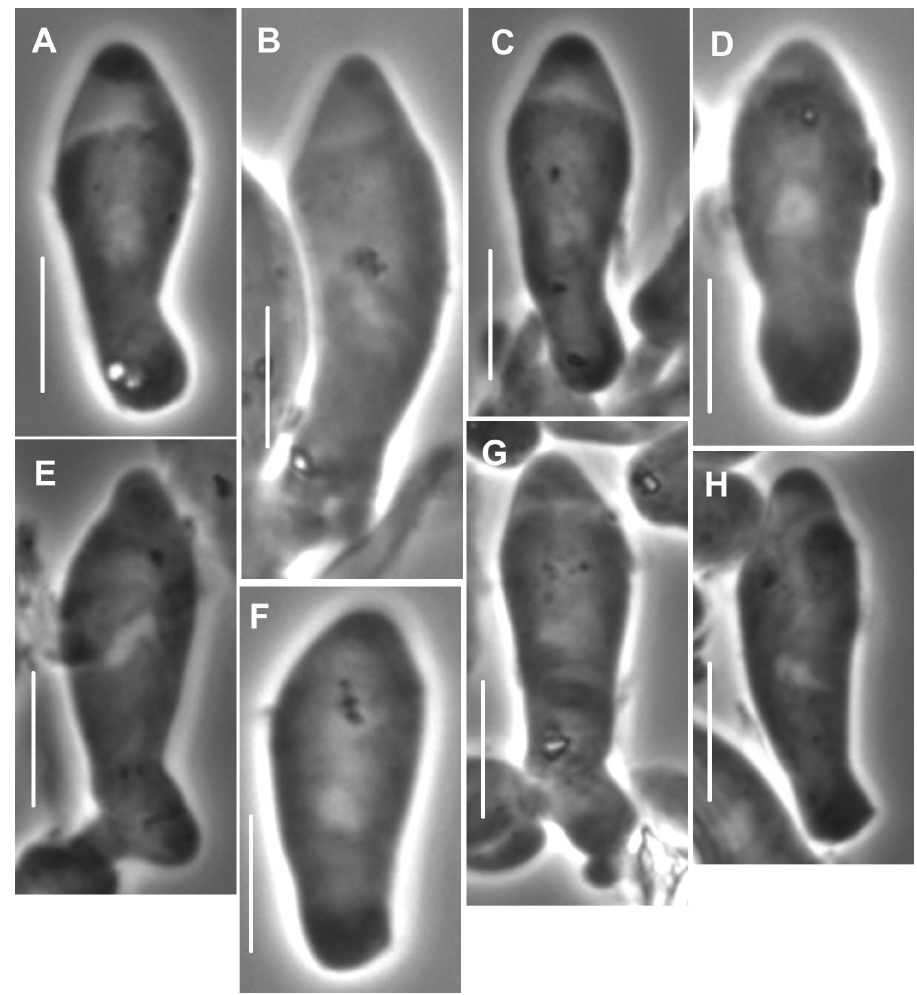
Figure 89. Mycetinis yunnanensis . Pleurocystidia. Note vague content partitioning in A–D, G,H. Note clamp connections in B, E, G . Standard bars = 10 µm. TFB 3146 (TENN-F- 49385).